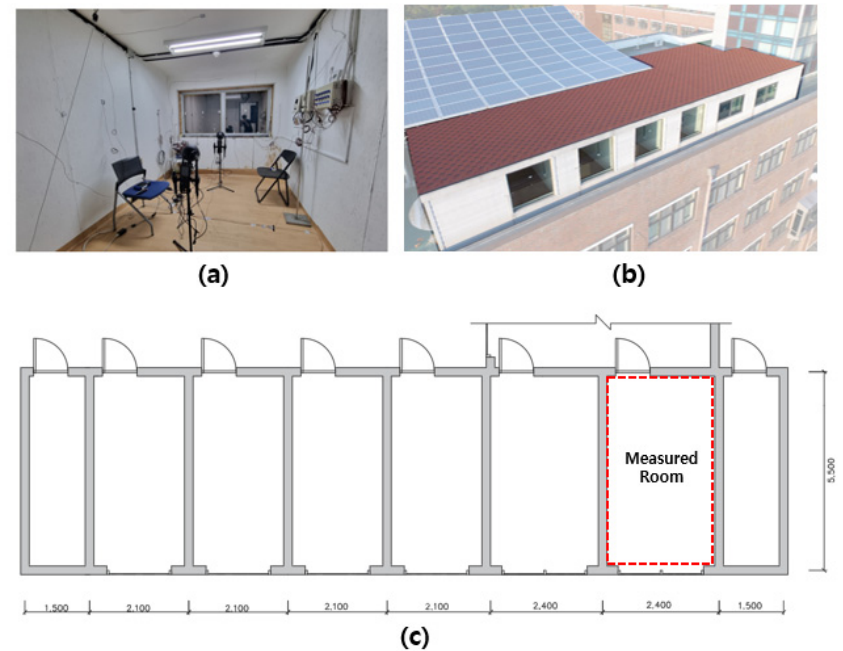
Figure 2. ( a ) Interior space of the chamber; ( b ) exterior view of the chamber; and ( c ) floor plan of the chamber.